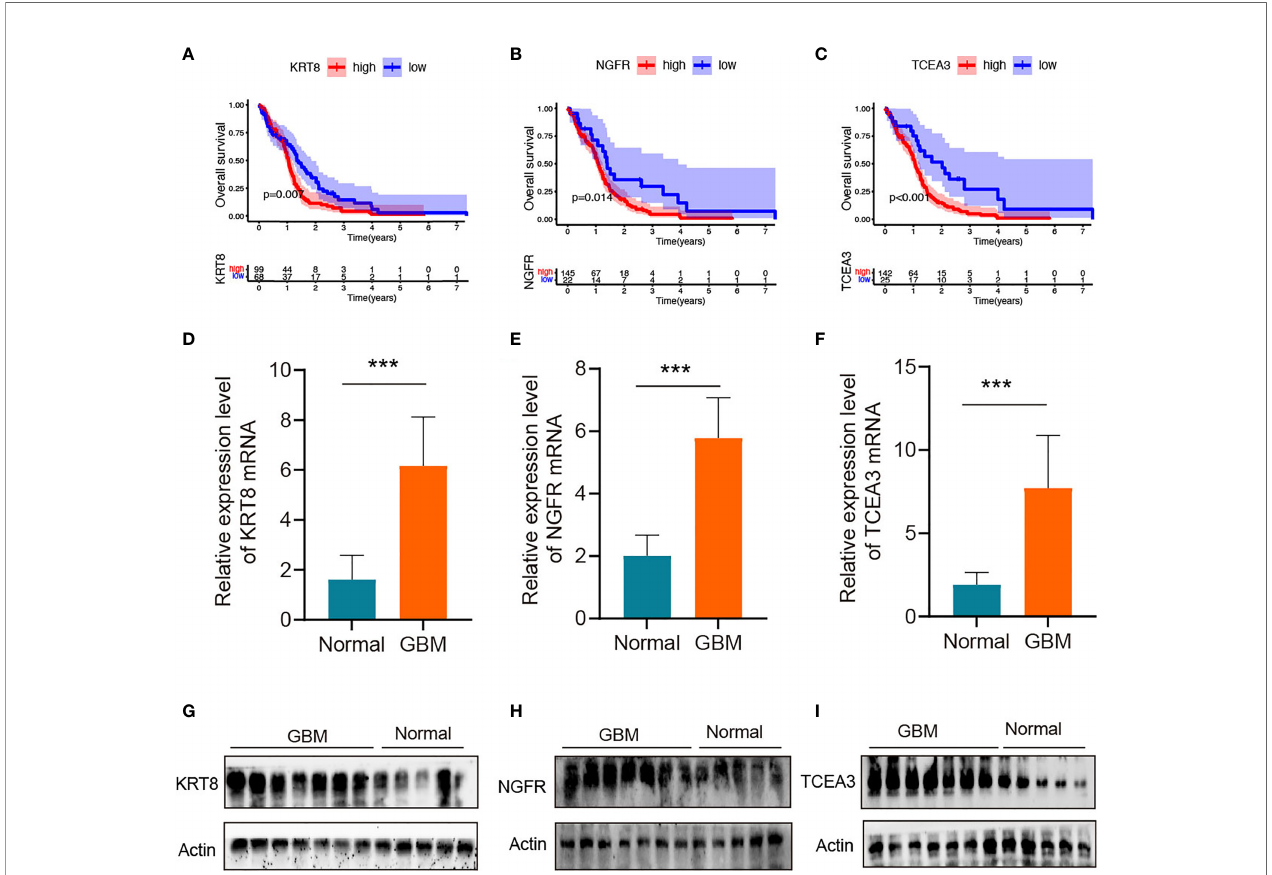
FIGURE 8 | Validation of the hub genes in clinical tissues (A – C) Kaplan – Meier survival curves for patients of GBM with high and low gene expression in the TCGA dataset. (D – F) qRT-PCR of KRT8, NGFR, and TCEA3 in clinical human GBM samples and normal brain tissues. The expression levels were normalized to b -actin. ***P < 0.001. (G – I) The protein expression of KRT8, NGFR, and TCEA3 in clinical human GBM tissues and normal tissues was detected by